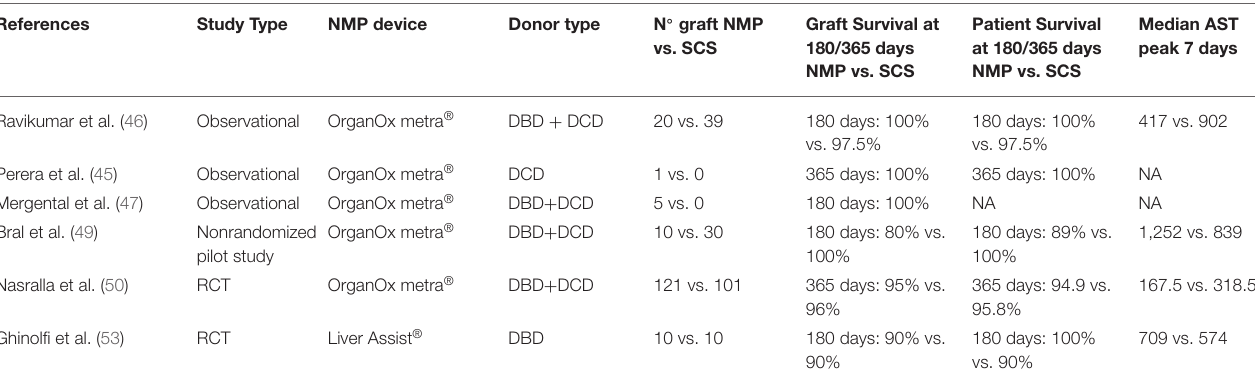
TABLE 1 | Outcomes of Normothermic machine perfusion